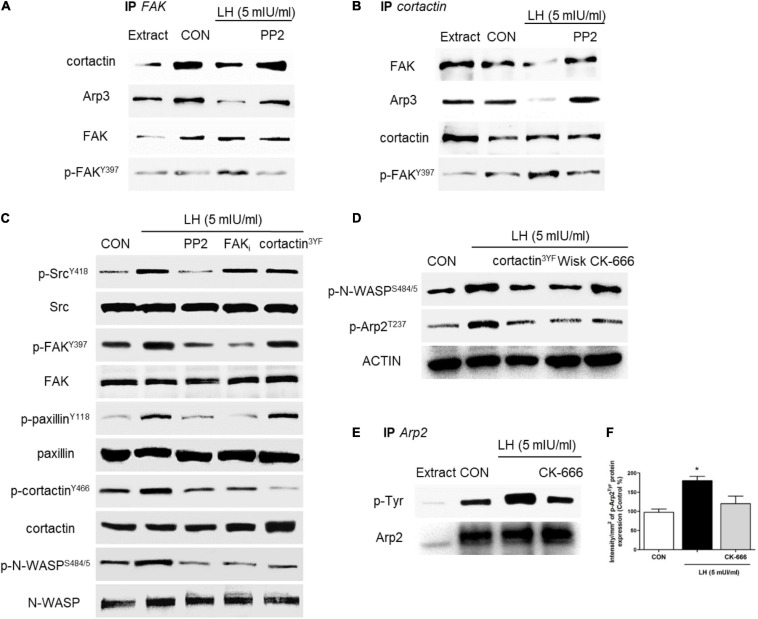
LH stimulates the Src/FAK/paxillin/cortactin/N-WASP and Arp2/3 complexes. (A,B) BC cells were exposed to LH (5 mIU/ml) for 20 min in the presence or absence of the c-Src kinase inhibitor PP2 (10 μM). Cell protein extracts were immunoprecipitated with an antibody vs. FAK (A) and cortactin (B). The immunoprecipitates (IPs) were assayed for co-immunoprecipitation vs. FAK, p-FAK, cortactin, and the Arp3 subunit. The membranes were re-blotted for the immunoprecipitated protein to show equal input. (C) Cells were incubated in the presence of LH (5 mIU/ml) for 20 min with or without PP2 (10 μM), FAK (1 μM), and/or dominant negative constructs vs. cortactin (cortactin3YF). The total cell amounts of wild-type c-Src, FAK, paxillin, cortactin, and N-WASP or p-SrcY416, p-FAKY397, p-paxillinY118, p-cortactinY466, and p-N-WASPS484/485, respectively, are shown by western blot. (D) BC cells were transfected with the dominant negative constructs of cortactin (cortactin3YF), the specific inhibitor of N-WASP (Wiskostatin, 10 μM), and/or the inhibitor of the Arp2/3 complex (CK-666, 4 μM) and incubated in the presence of LH (5 mIU/ml) for 20 min. Phospho-N-WASPS484/485 and phospho-Arp2T237 were assayed by western blot analysis. (E,F) T-47D cells were exposed to LH (5 mIU/ml, 20 min) in the presence or absence of CK-666. Cell protein extracts were immunoprecipitated (IP) with an antibody vs. Arp2. IP was assayed for co-immunoprecipitation vs. p-Tyr. The membranes were re-blotted for the immunoprecipitated protein vs. Arp2 to show equal input. All experiments were performed in triplicate with consistent results; representative images are shown. *P < 0.05 vs. CON, control.